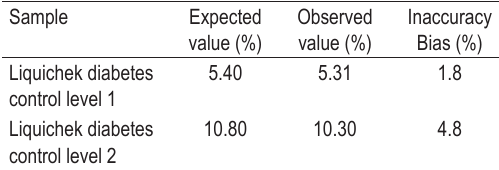
TABLE 1. Inaccuracy of HbA1c assay